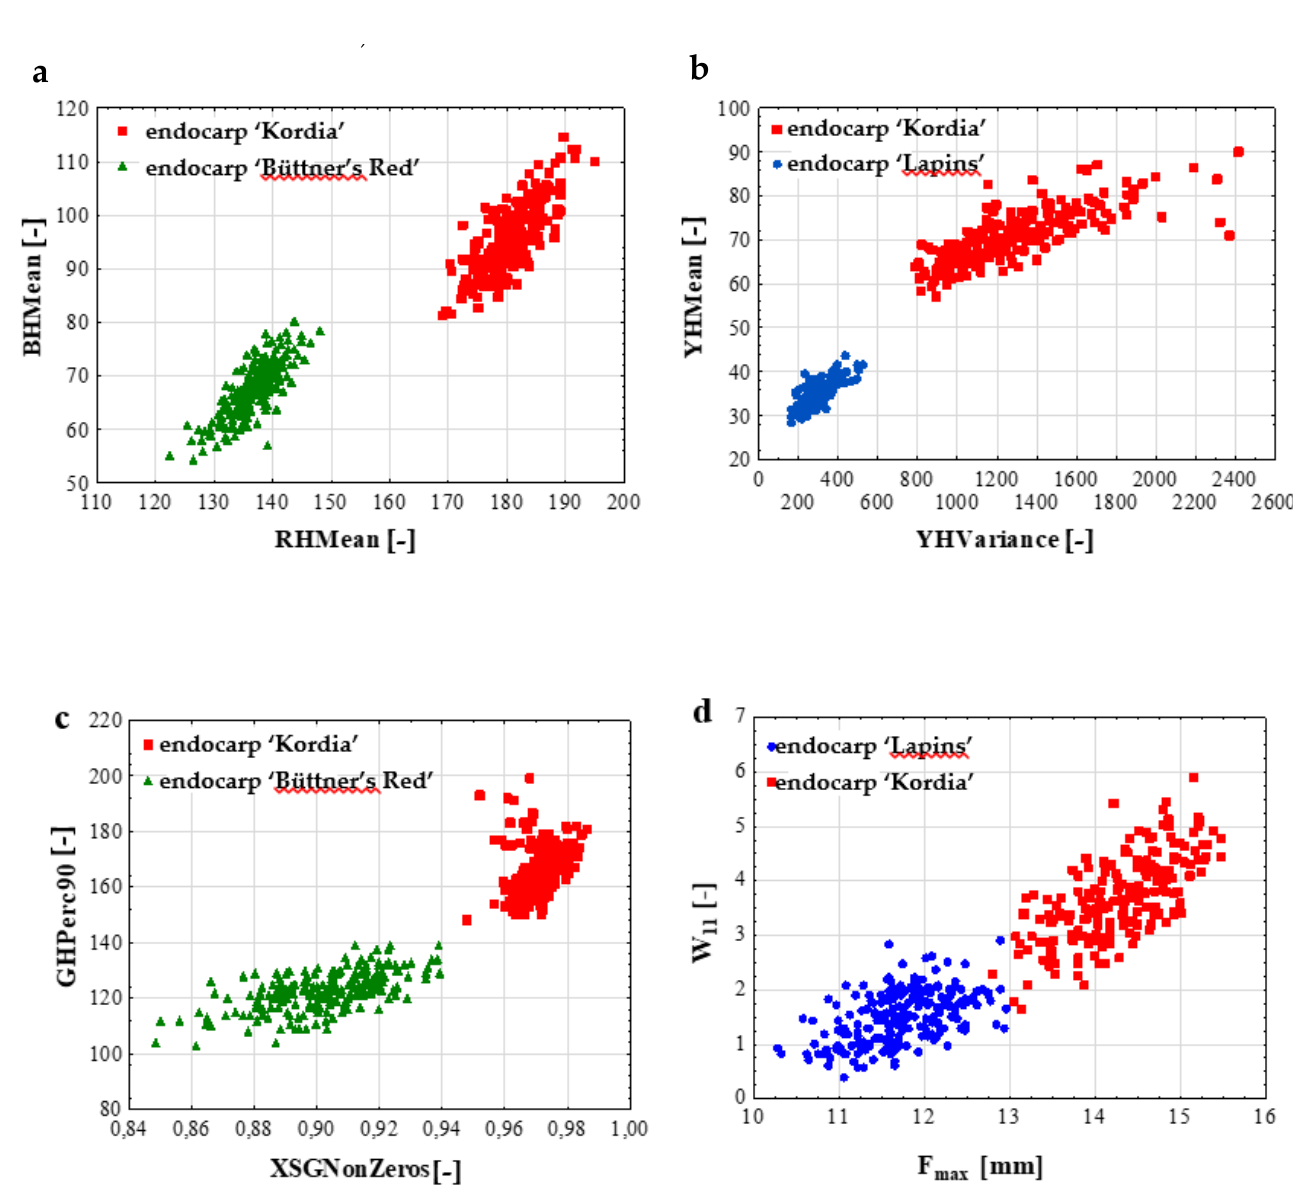
Figure 3. The scatter plots for: ( a ) two selected textures from RGB color space for endocarp ‘Kordia’ and ‘Büttner’s Red’, ( b ) two textures of endocarp from channel Y for endocarp ‘Lapins’ and ‘Kordia’, ( c ) one texture from RGB color space and one texture from XYZ color space for endocarp ‘Kordia’ and ‘Büttner’s Red’, ( d ) two geometric features for endocarp ‘Lapins’ and ‘Kordia’; [-]—no unit.